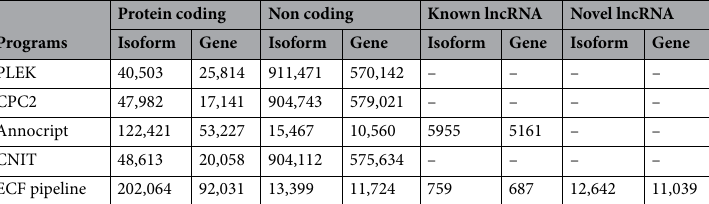
Table 1. Performance of lncRNA identification tools and ECF pipeline on whole Androctonus crassicauda